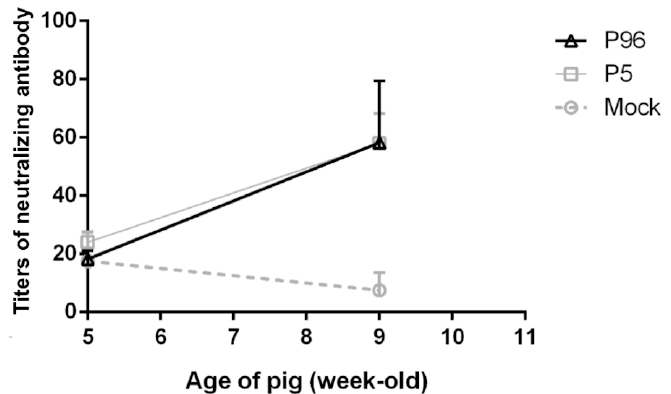
Figure 6. Changes in plasma PEDV neutralizing antibody levels after inoculation with PEDV strain Pintung 52 (PEDVPT)-P5 or PEDVPT-P96. The plasma samples were collected from 5- and 9-week-old (0 and 27 DPI) pigs, and neutralizing antibody assay was performed. Values are represented as mean ± SEM. The black, gray, and dashed lines illustrate the results of the PEDVPT-P96-inoculated group, PEDVPT-P5-inoculated group, and mock-infected group, respectively.